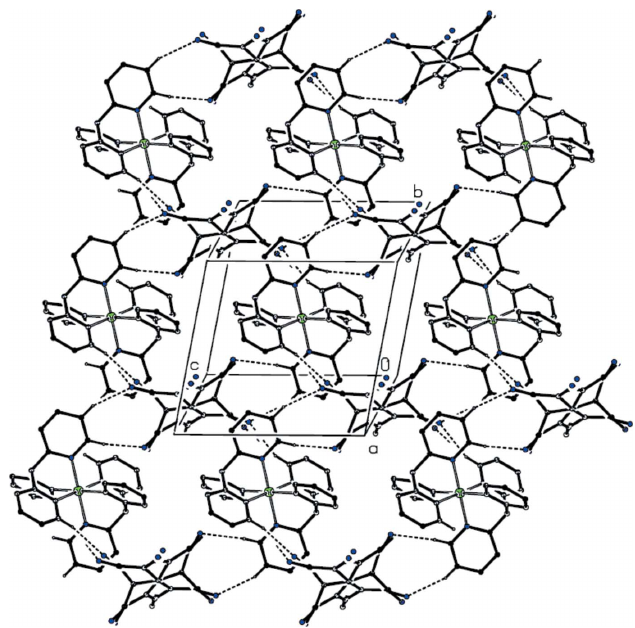
Figure 2 Part of the crystal structure showing the formation of a hydrogen-bonded sheet lying parallel to (100). Hydrogen bonds are drawn as dashed lines and, for the sake of clarity, H atoms not involved in the motif shown have been omitted. Each anion site is occupied by one of the two possible orientations of the anion, distributed at random.